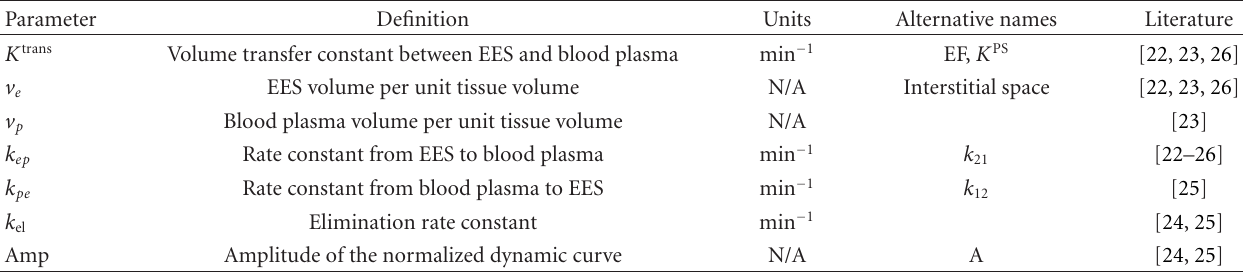
Table 1: Pharmacokinetic parameters often used in DCE-MRI pharmacokinetic analysis.